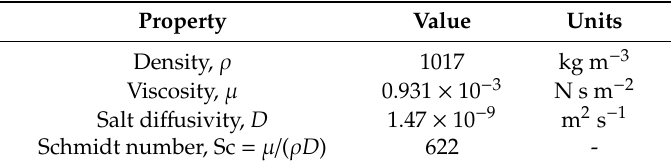
Table 3. Physical properties of the simulated solution (500 mol / m 3 NaCl at 25 ◦